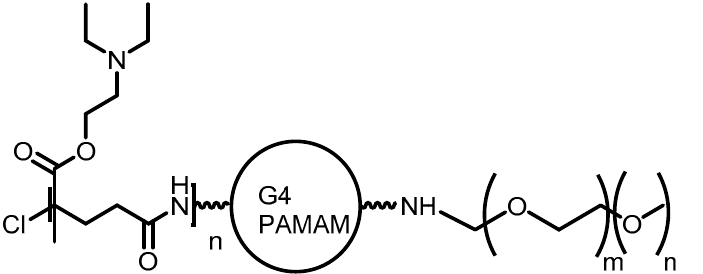
Figure 11. PAMAM dendrimer derivative, poly(2-( N , N -diethylamino)ethyl methacrylate) with methoxy-poly(ethylene glycol)-poly(amido amine) for 5-FU encapsulation [73].